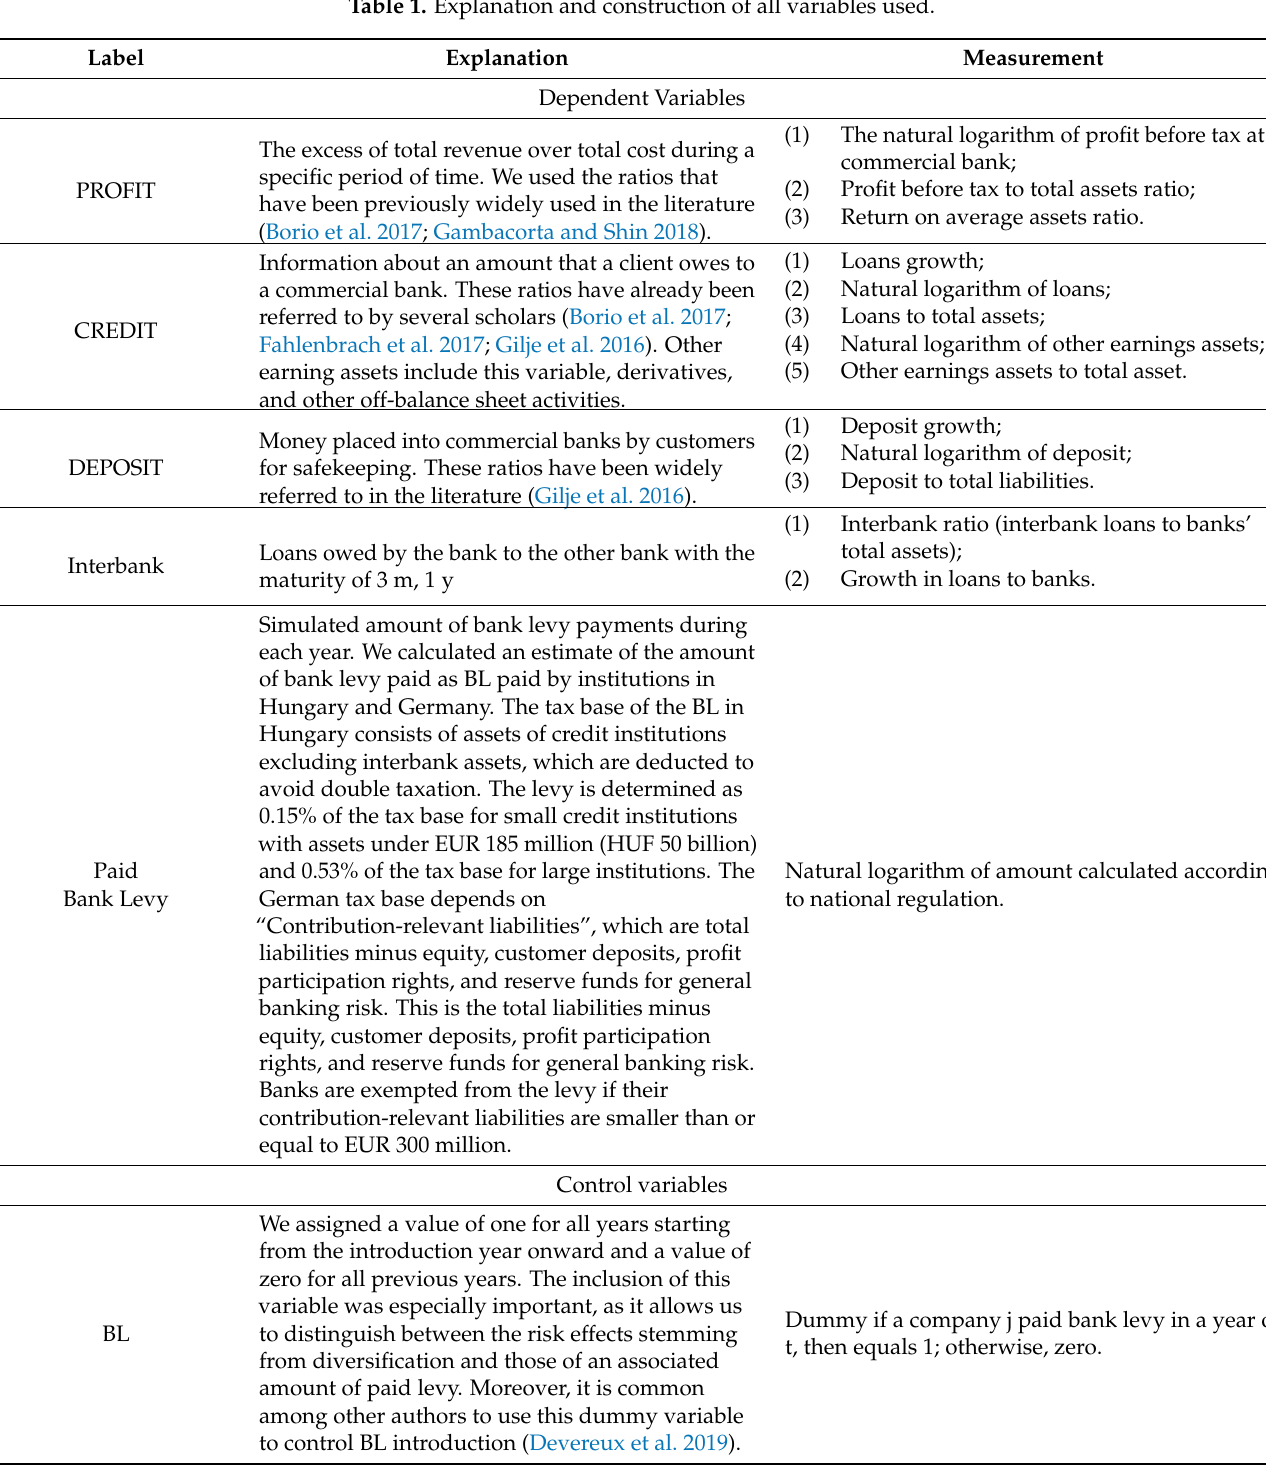
Table 1. Explanation and construction of all variables